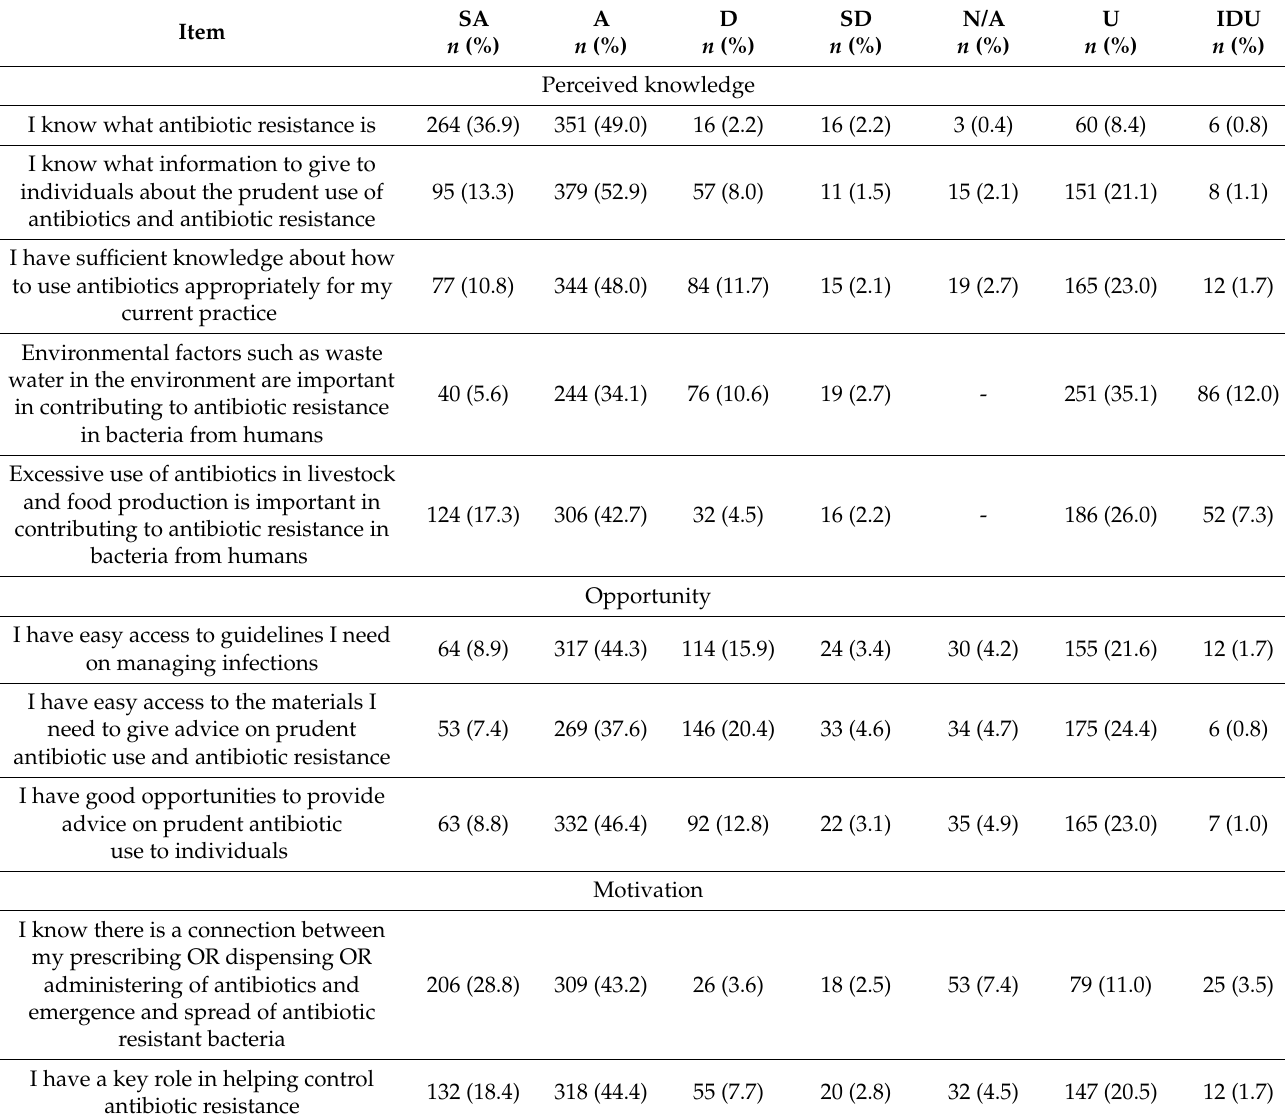
Table 4. Perceived knowledge, opportunity and motivation of respondent students regarding antibi- otic use and resistance ( n =